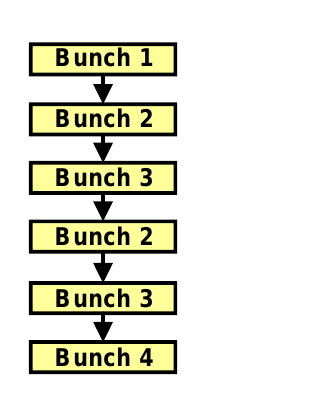
Fig. 4. CNN layers connection with respect to